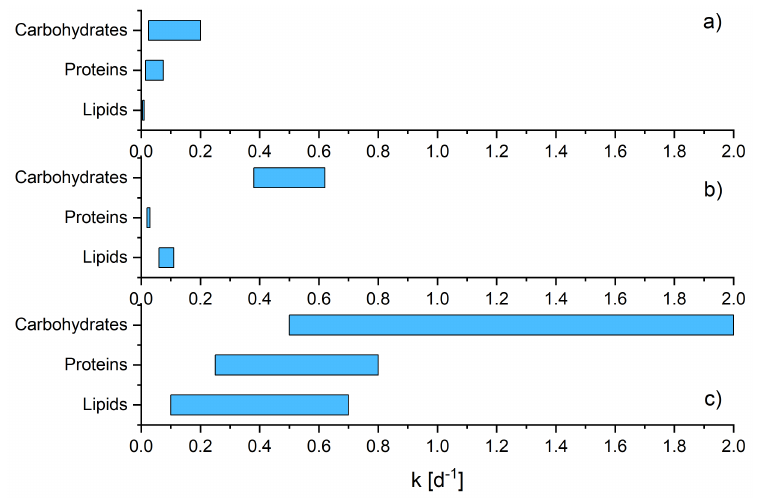
Figure 1. k hyd -values for carbohydrates, proteins and lipids evaluated by Christ et al. [19] ( a ), Gujer [20] with data of O’Rourke [21] ( b ) and Garcia-Heras [22] in [23] ( c )